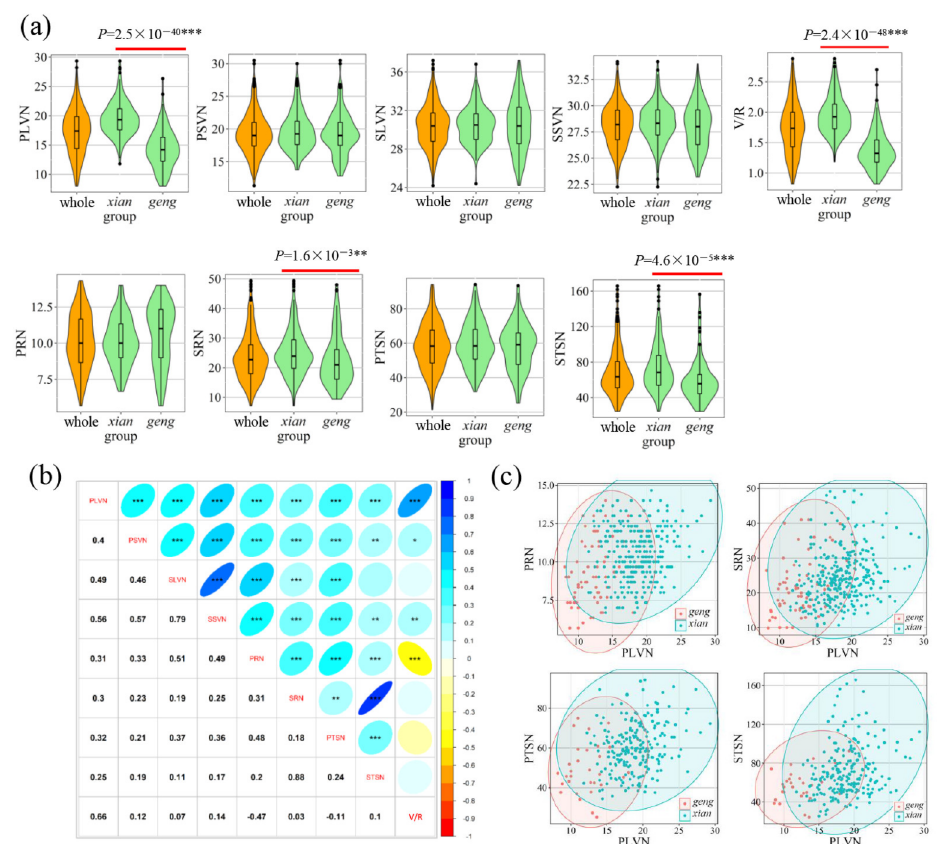
Figure 1. Values and correlations of flow- and sink-related traits. ( a ) Box plots of the nine flow- and sink-related traits in whole, xian, and geng population panels. Orange and light green colors indicate whole population and subpopulations ( xian and geng ), respectively. ** and *** denote the significance of Student’s t-test at p < 0.01 and p < 0.001, between xian and geng , respectively. ( b ) Correlations between the nine tested traits. The values are correlation coefficients. The areas and colors of ellipses correspond to absolute values of the corresponding r. Right and left oblique ellipses indicate positive and negative correlations, respectively. Values without glyphs were insignificant at the 0.05 probability level. *, **, and *** represent significant correlations at p < 0.05, p < 0.01, and p < 0.001, respectively. ( c ) Relationship between PLVN and four sink-related traits in xian and geng subpopulations. PLVN: number of large vascular bundles in panicle neck; PSVN: number of small vascular bundles in panicle neck; SLVN: number of large vascular bundle in second internode; SSVN: number of small vascular bundle in second internode; PRN: number of primary rachis branches; SRN: number of secondary rachis branches; PTSN: total spikelets number on primary rachis branches; STSN: total spikelets number on secondary rachis branches; V/R: number of large vascular bundles in panicle neck to number of primary rachis